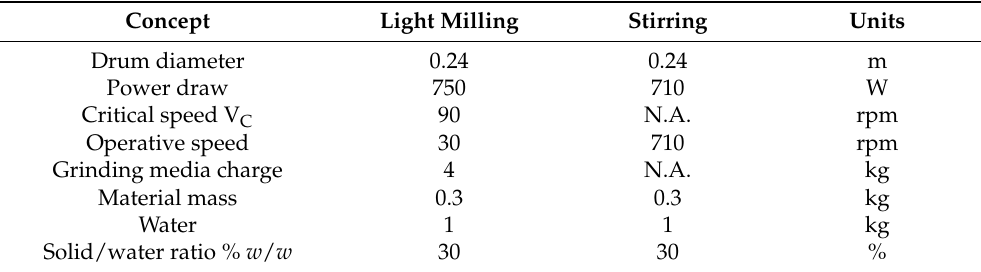
Figure 2. Attrition devices used in this study. ( A ) view of the attrition cell, ( B ) Plot of the attrition cell, ( C ) plot of the tumbling mill , ( D ) view of the tumbling mill. Table 1. Operative condition of the attrition equipment, batch mill and agitator